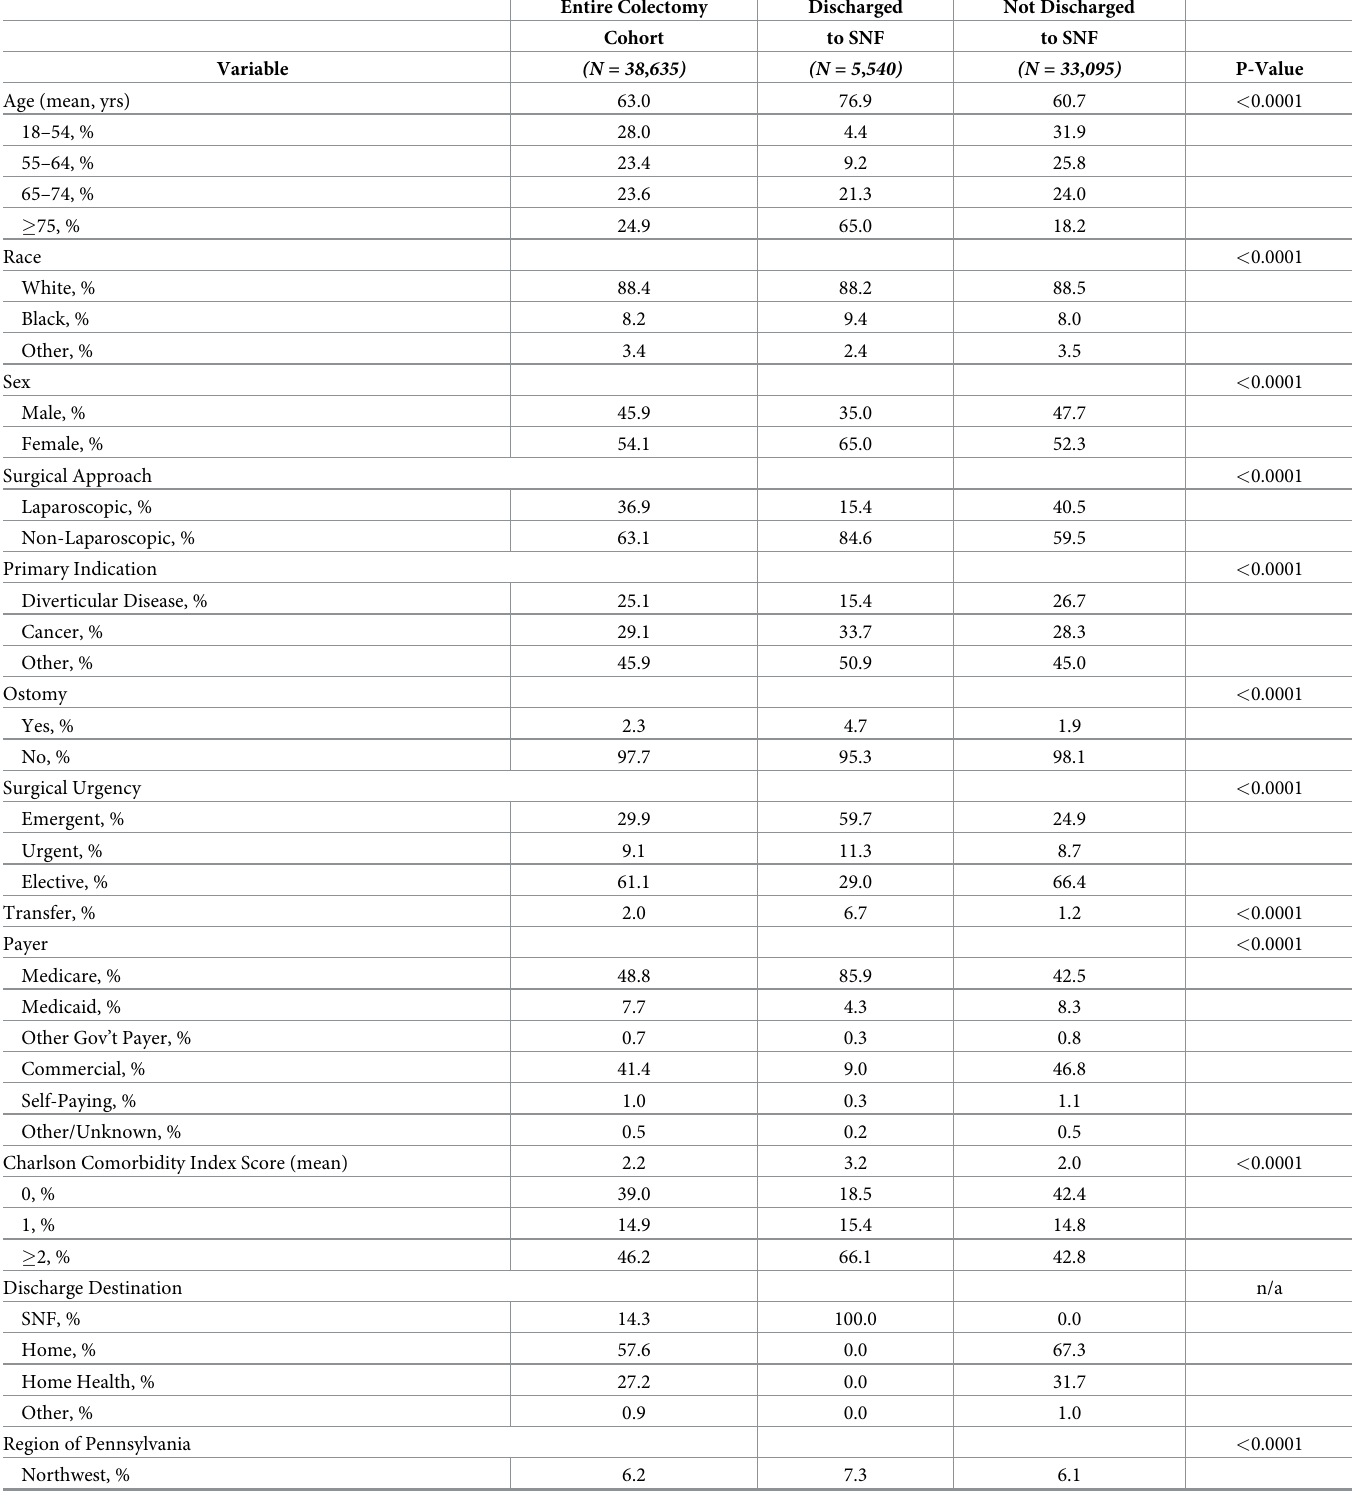
Table 1. Demographic characteristics and selected outcomes for the colectomy cohort prior to matching, stratified by discharge to